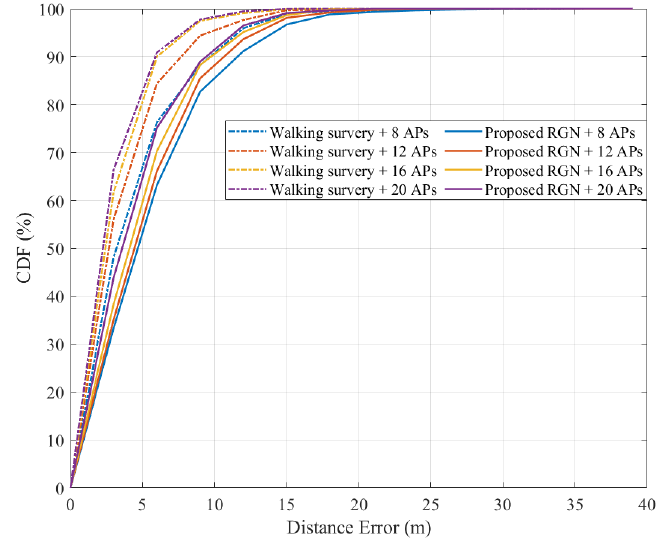
using the walking survey and the RGN in the cumulative distribution function (CDF)